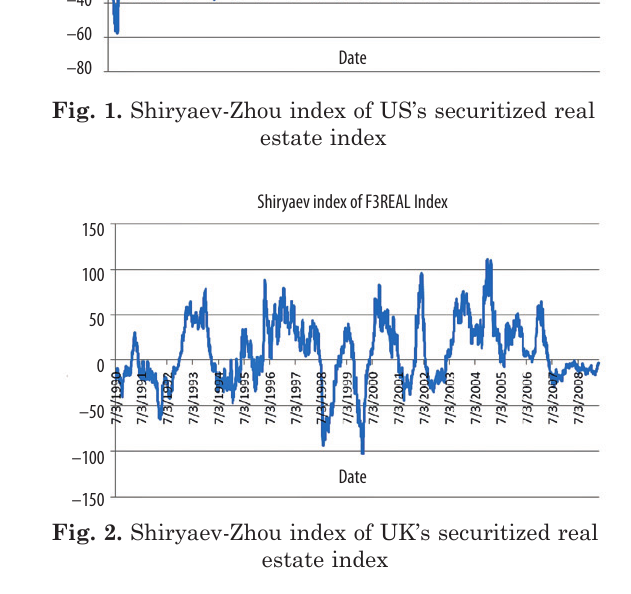
Fig. 2. Shiryaev-Zhou index of UK’s securitized real estate index